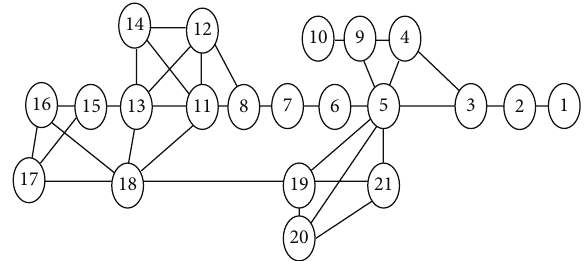
Figure 3: Distribution of the attractions of Dajue Temple.